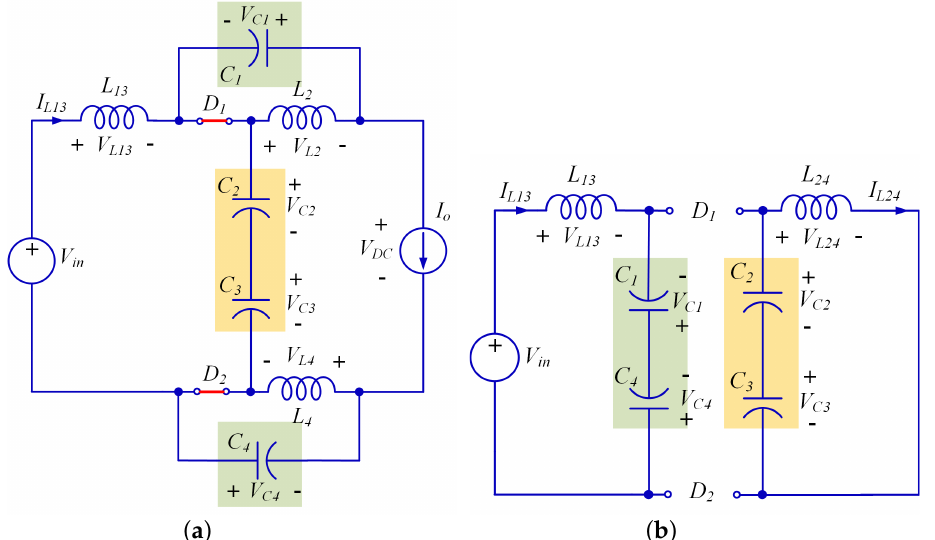
Figure 2. The model of qZS network. ( a ) in the non-shoot-through state; ( b ) in shoot-through state